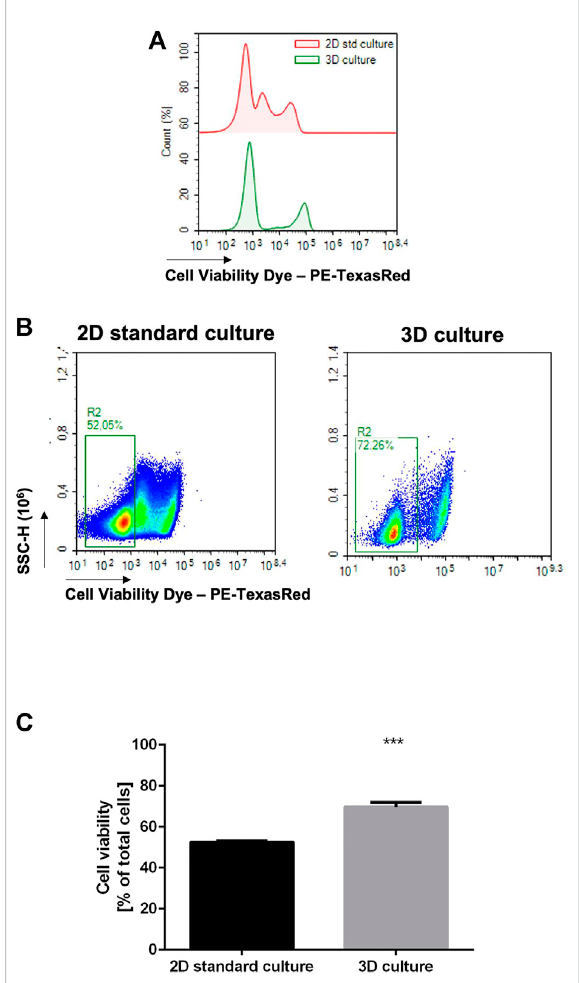
FIGURE 1 3D alginate embedding does not negatively affect cell viability. NK cells were cultured in the standard setting ( n = 6) or in 3D alginate hydrogel ( n = 6) for 24 h. The cells were then recovered and stained with a Fixable Cell Viability Dye (PE- TexasRed). (A) Flow cytometry analysis on NK cells, histograms: three distinct populations are observed in the 2D standard culture. (B) Flow cytometry analysis on NK cells showing % of low-staining population. (C) Statistical analysis of (B)